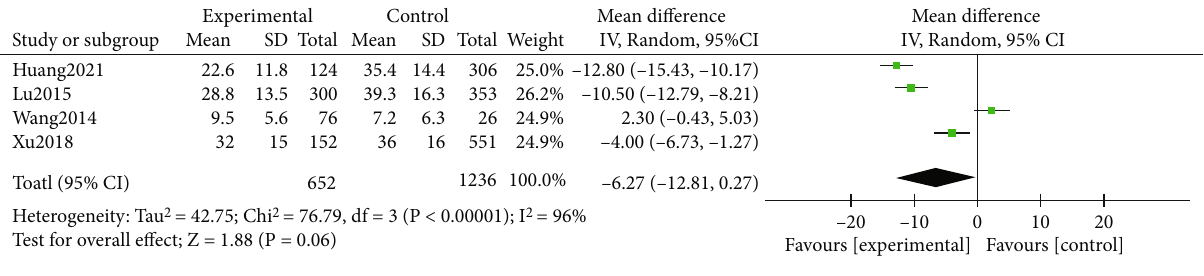
Figure 6: Estimated MD summary for lymphocytes (%).